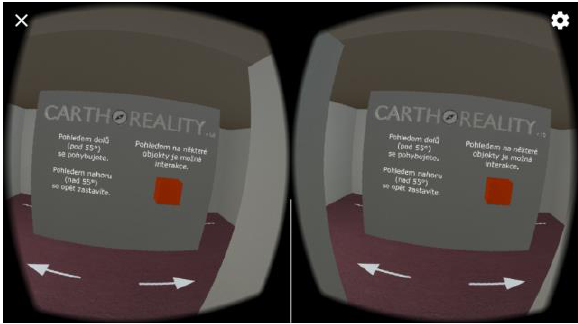
Figure 6. Instructions for control and interaction at the entrance to the virtual map room. Screen is divided for display in a low cost headset.